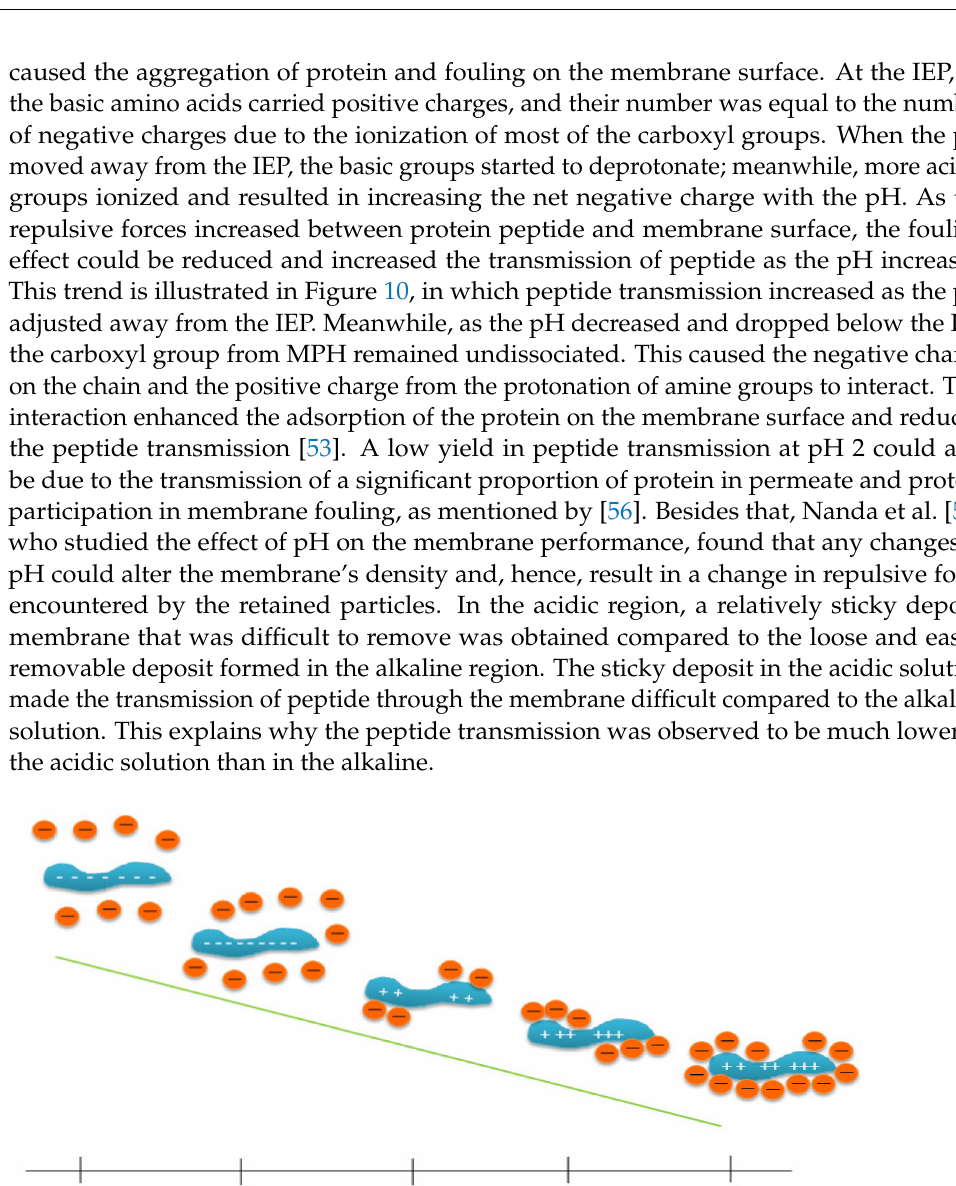
pH 2 (79.26 ± 0.50%) and decreased at pH 4 (28.91 ± 0.38%) and pH 7 (22.16 ± 1.49%).